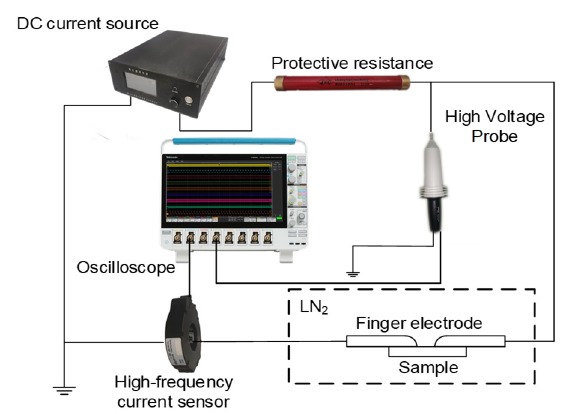
Figure 2. DC surface discharge and flashover voltage test device.